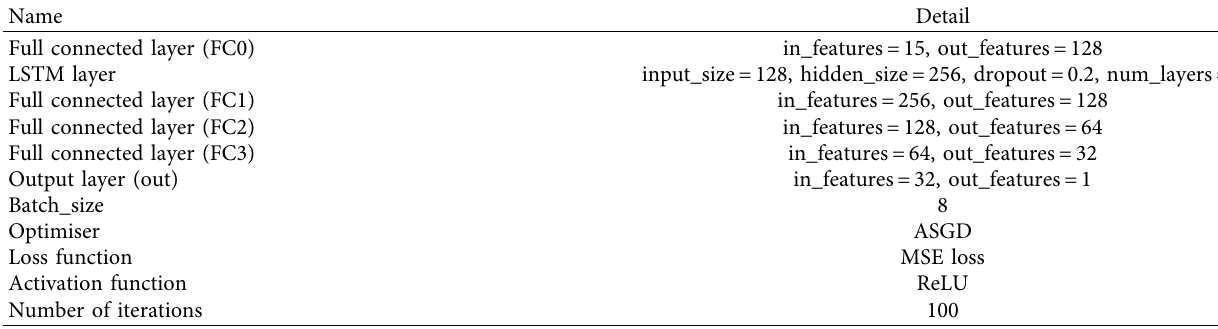
Table 3: Network parameter setting.